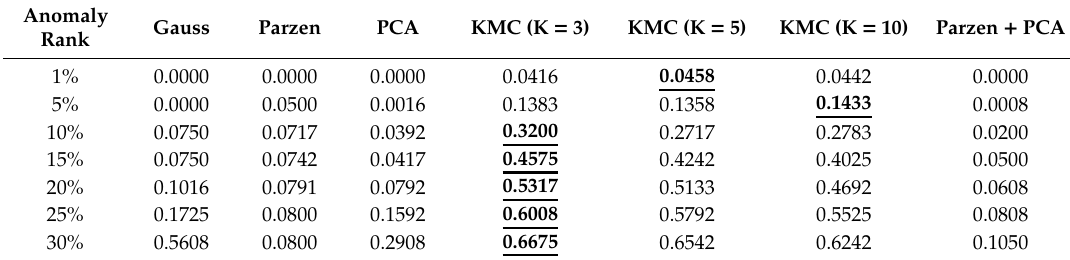
Table 13. True detection rate of each anomaly detection algorithm based on the e-mail contents dataset (Electrical Engineer). Best performance is shown in bold and underlined (number of normal behaviors in the test set: 69,405, number of malicious behaviors in the test set: 13).